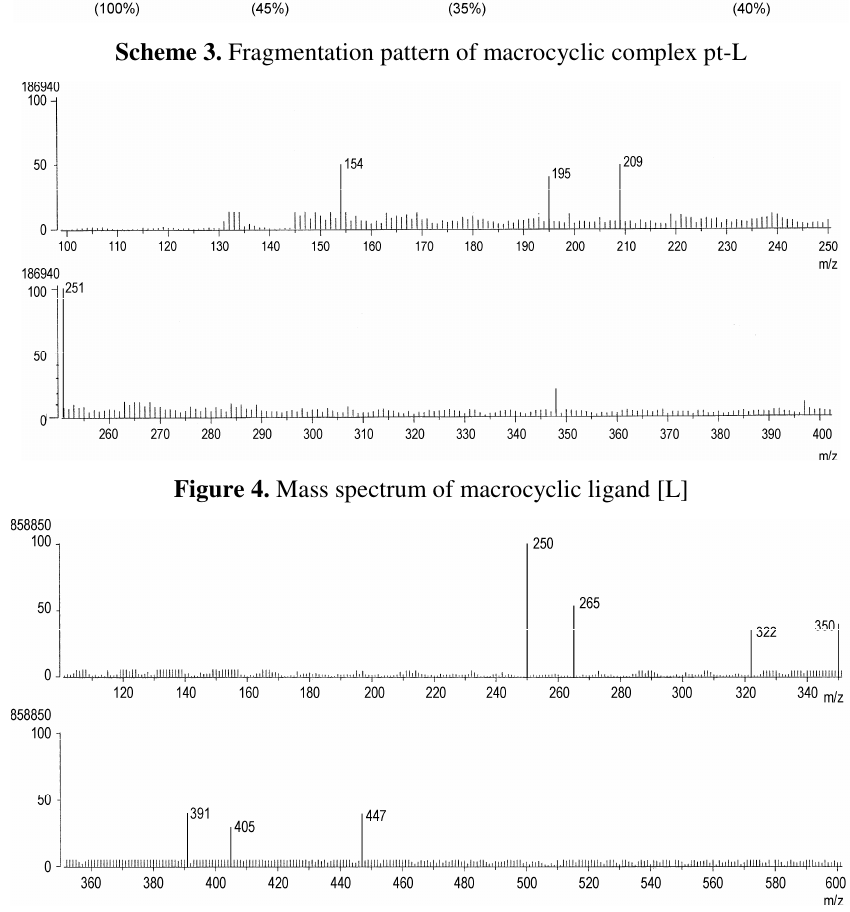
Figure 5. Mass spectrum of macrocyclic complex[Pt-